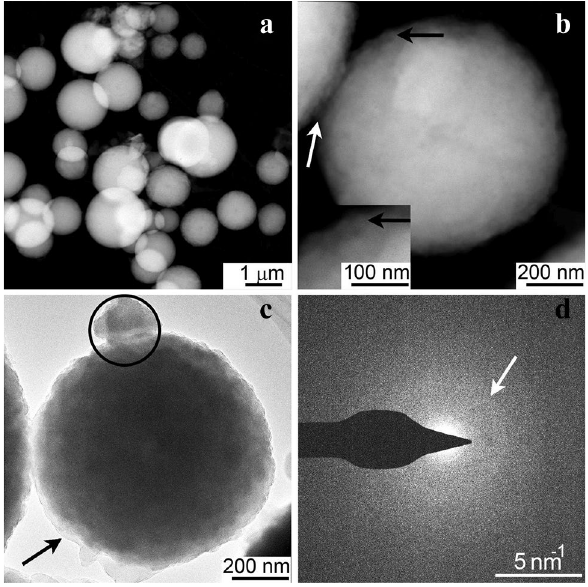
Figure 2. TEM images showing the morphology and structure of the FSY HACC precipitated by Fuligo septica . ( a ) Low-magnification HAADF-STEM image of the peridial HACC spheres. ( b ) HAADF-STEM and ( c ) BFTEM images of one sphere. Black arrow marks ~ 30 to 40-nm size quasi-spherical features. Imaged processed to more clearly reveal the internal clumping is shown in Fig. S3. ( d ) SAED pattern acquired from the circled area in ( c ). White arrow points to a diffuse diffraction ring with ~ 0.29 nm